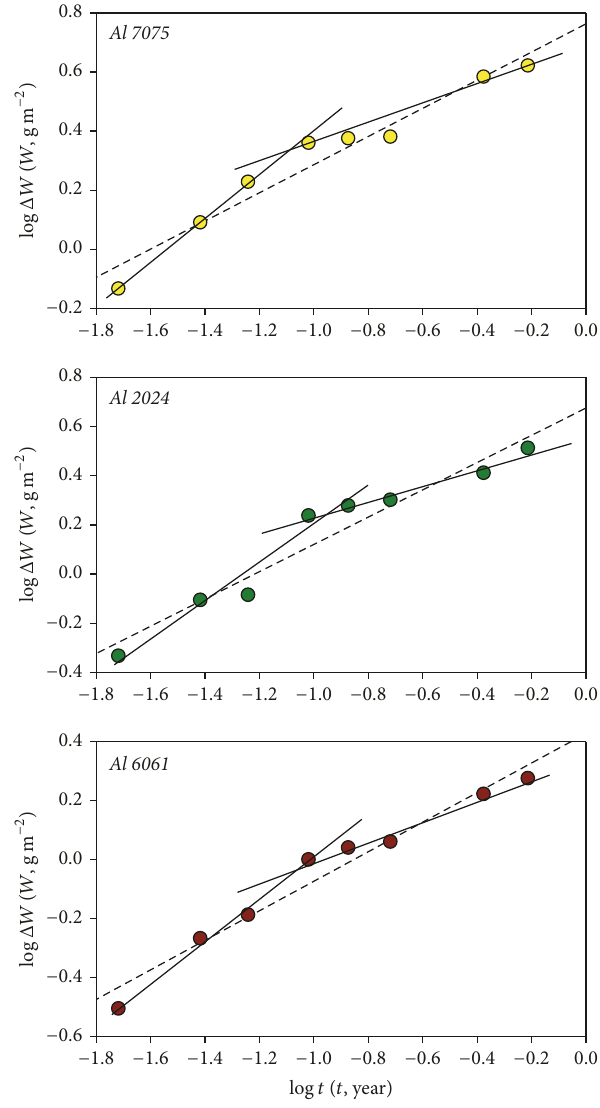
Figure 6: log Δ𝑊 versus log 𝑡 for Al alloys immersed in the Red Sea